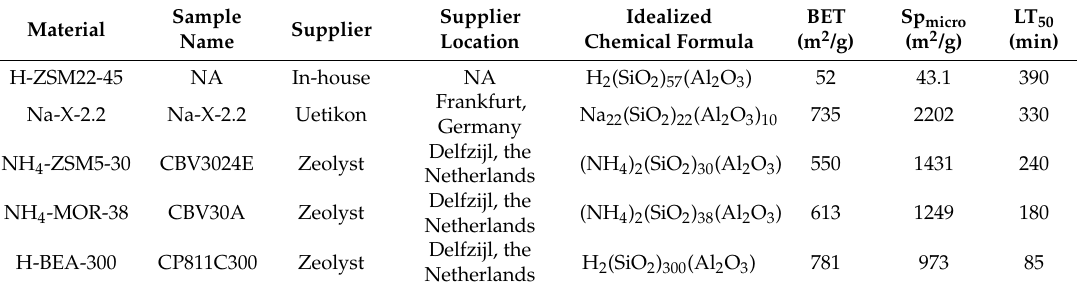
Table 6. Zeolite samples, their origin and composition. The zeolite sample notation is structured A-B-X with A the cation exchanged in the zeolite, B the zeolite name and X the silica over alumina (SiO 2 /Al 2 O 3 ) ratio of the material. BET is the BET specific surface area, Sp micro is the microporous surface area of the material and LT 50 is median survival time of M. pharaonis foragers exposed to the zeolite, all of which were previously determined